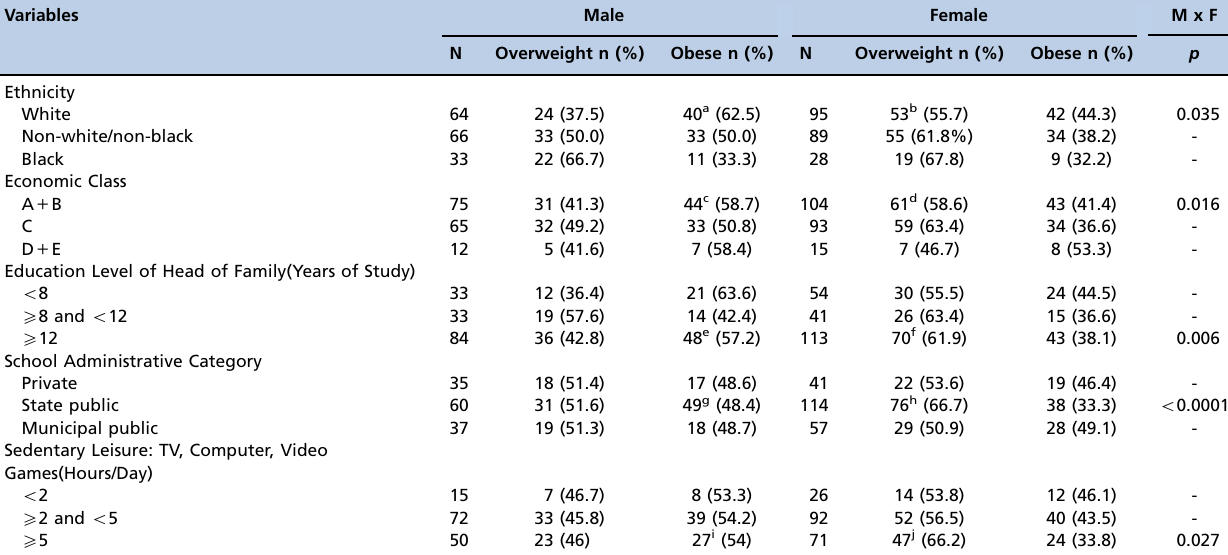
Table 2 - Prevalence rates of overweight and obesity grouped according to gender and demographic and socioeconomic variables. Variables